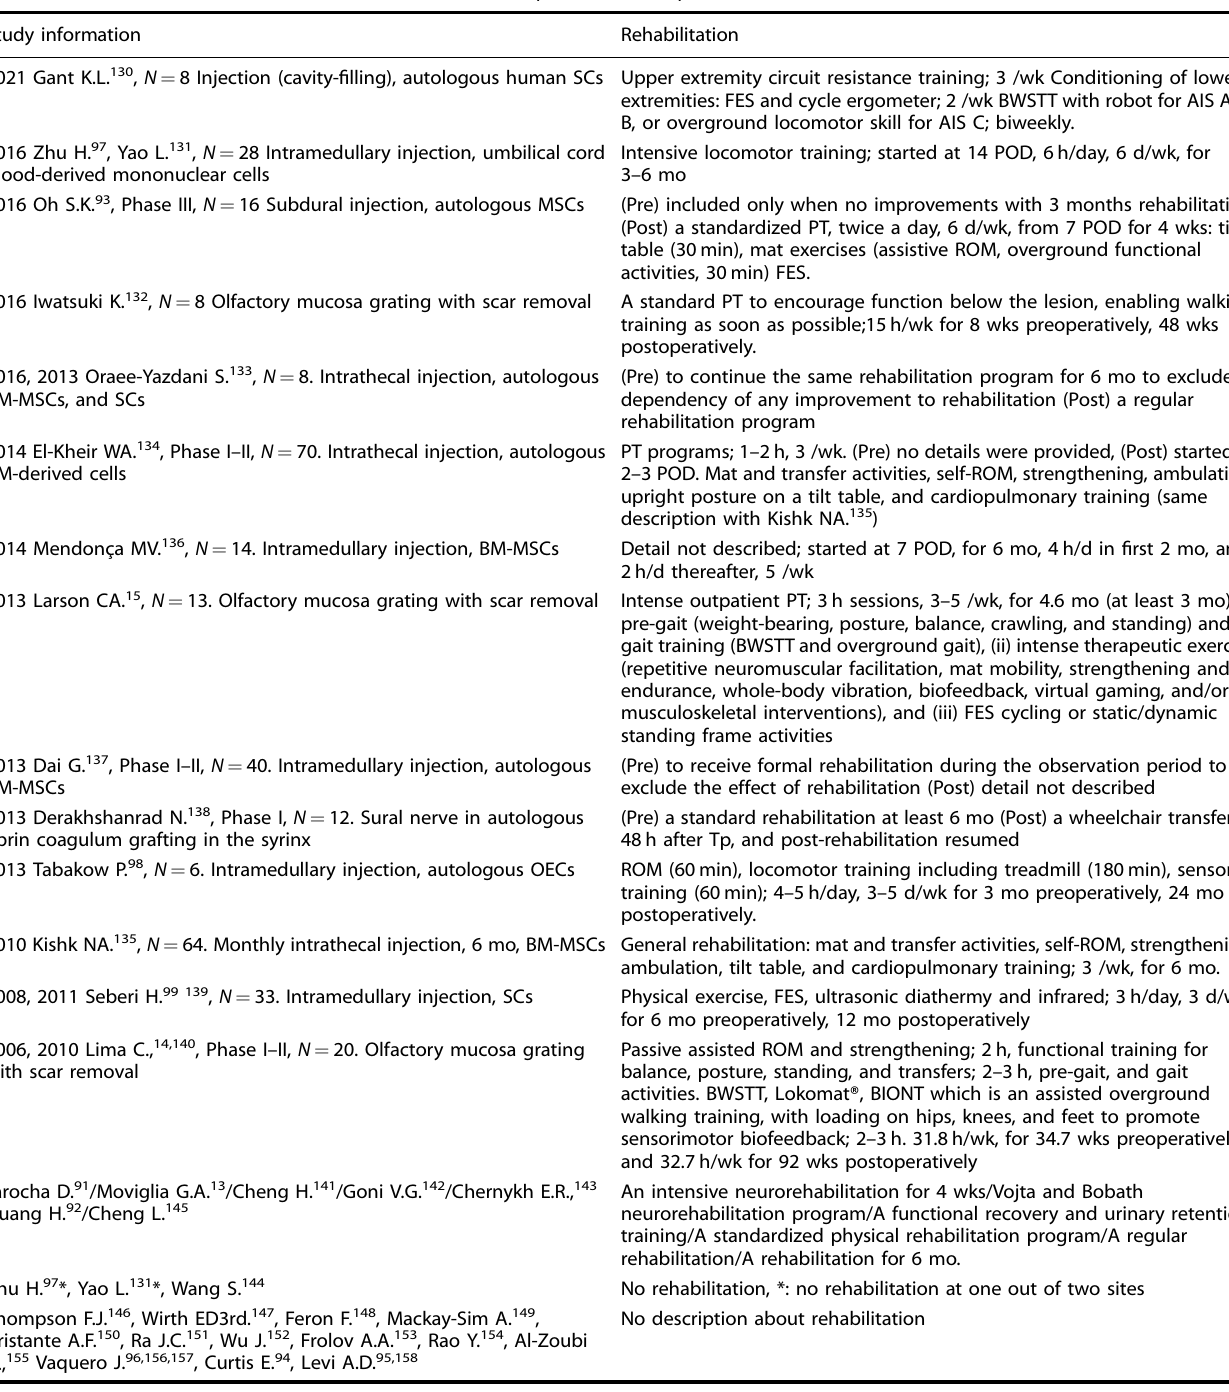
Table 3. SCI rehabilitation in clinical studies on stem cell therapies for chronic patients. Study information